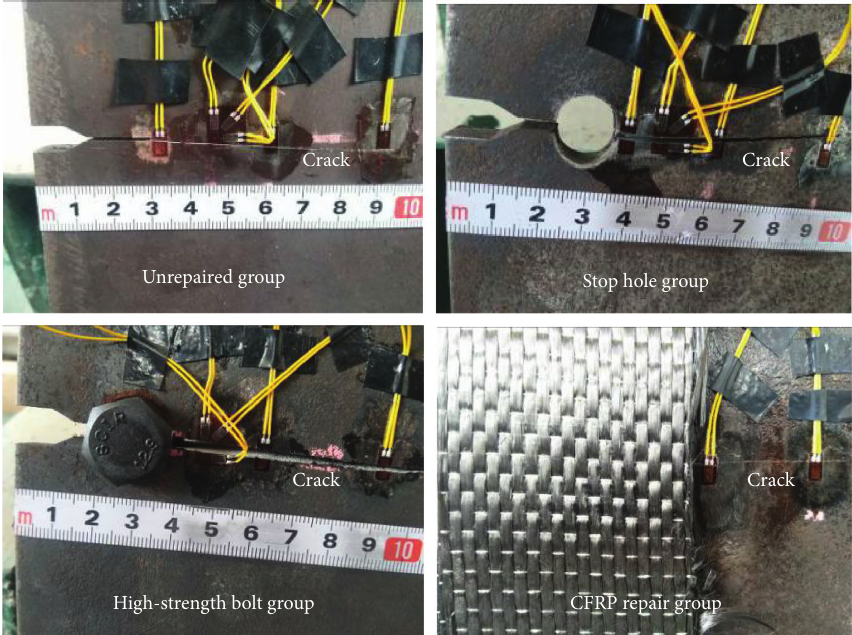
Figure 18: Typical fatigue cracking of